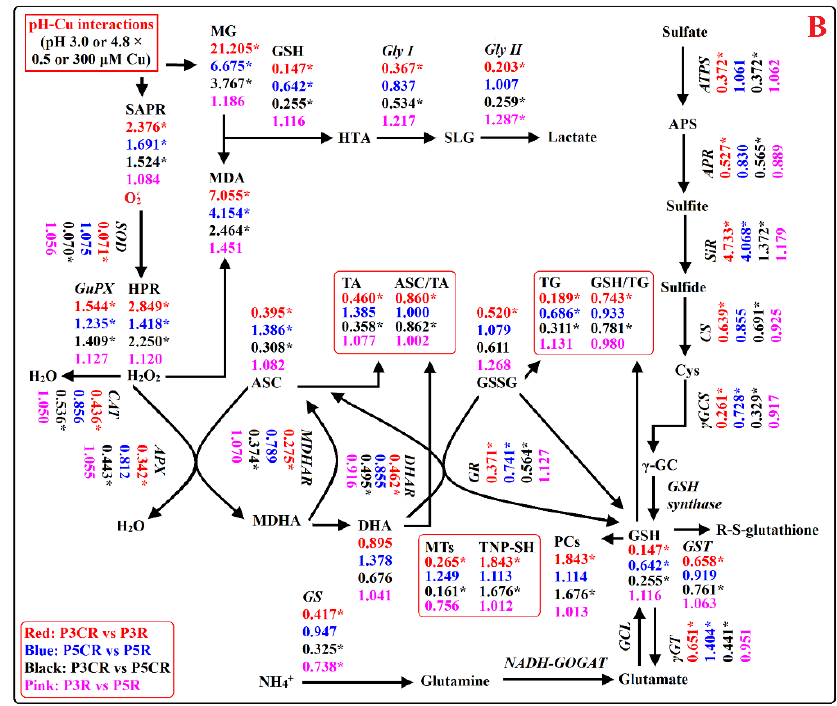
Figure 7. A diagram displaying the effects of Cu–pH interactions on ROS and MG metabolisms in leaves ( A ) and roots ( B ). In this figure, we used italics for enzymes and plain format for metabolites. An asterisk indicates a significant difference between two treatments of a comparative group at p < 0.05. An enzyme or metabolite was considered increased (decreased) when it had both a relative change of more (less) than 1 and a p -value of < 0.05. P3L, pH 3.0 + 0.5 μM Cu-treated leaves; P3R,